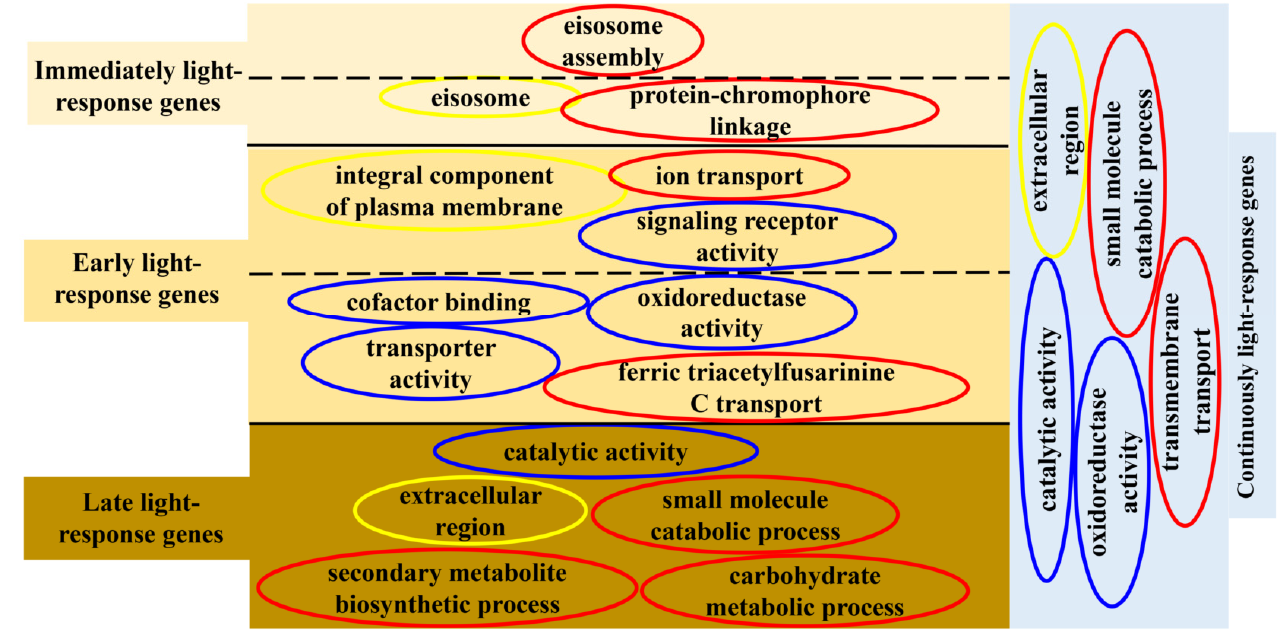
Figure 11. Gene-function clustering of immediately, early, late, and continuously light-responsive genes. Red box represents biological process, yellow box represents cellular component, and blue box represents molecular function. The dotted line represents the repeated GO terms between two adjacent light response periods.